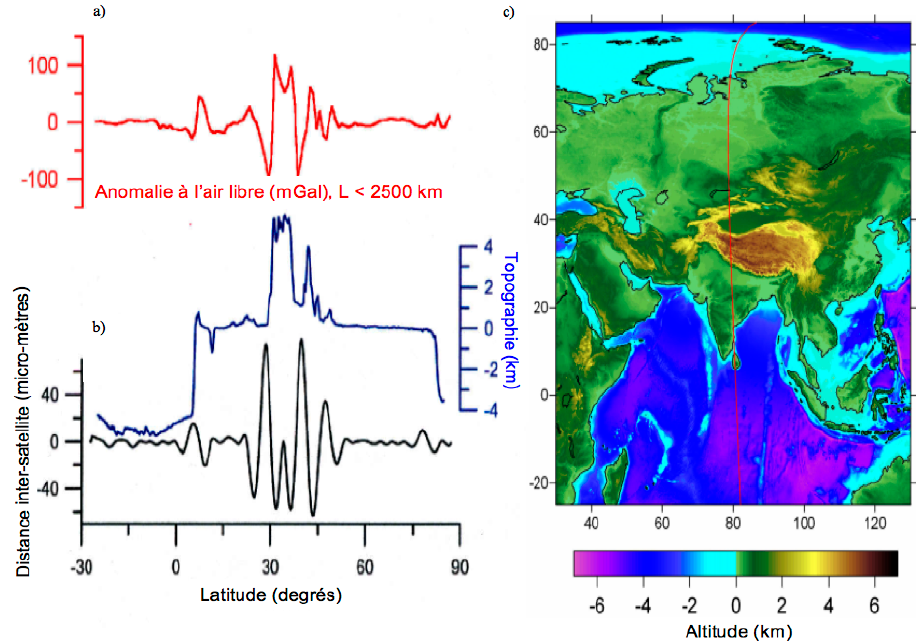
Figure 2. Variations against the latitude of the free air gravitational anomaly (red) ( a ) correlated with the surface topography along the satellites trajectory (blue) and with changes in the inter-satellite distance (black) as measured by the K-band ranging (KBR) system ( b ). Corresponding ground track overflying part of the Indian Ocean, India, the mountainous region of Himalaya, Siberia, and the Arctic Ocean (red) ( c ). Source: